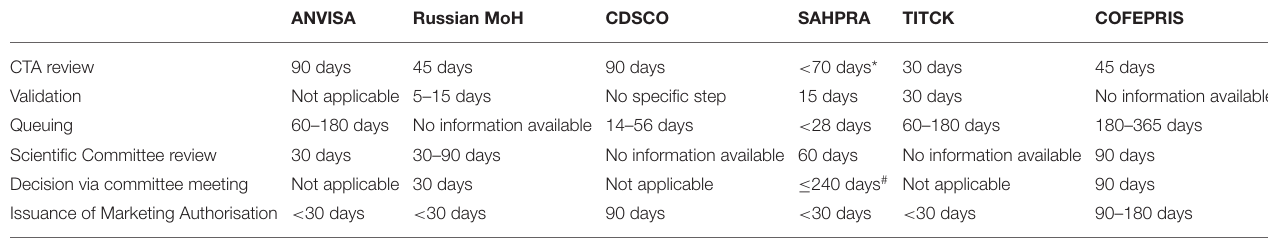
TABLE 5 | Timelines for biosimilar review and approval